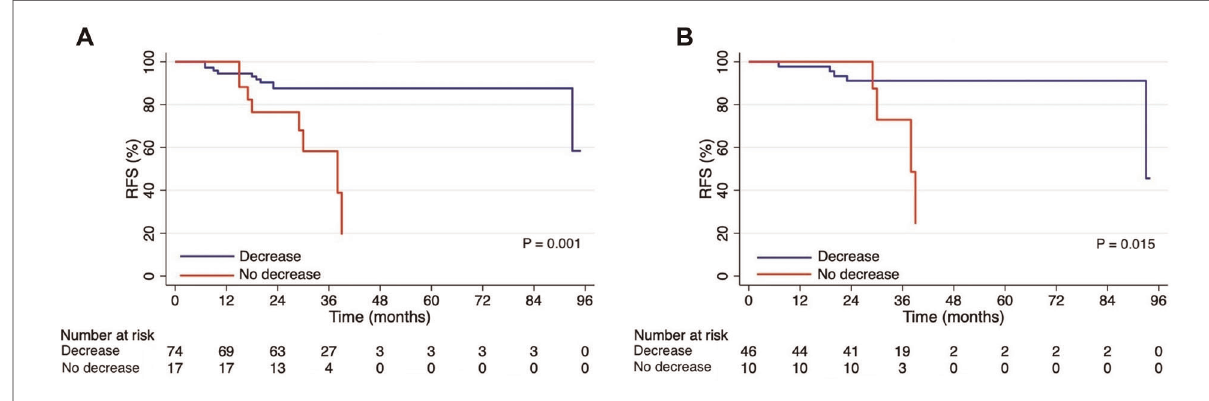
FIGURE 3 Kaplan-Meier curves display RFS by changes in progesterone levels. ( A ) Survival curves for the follow-up subgroup of 91 patients. ( B ) Survival curves for 56 patients with hormone receptors positive. RFS, relapse-free survival.